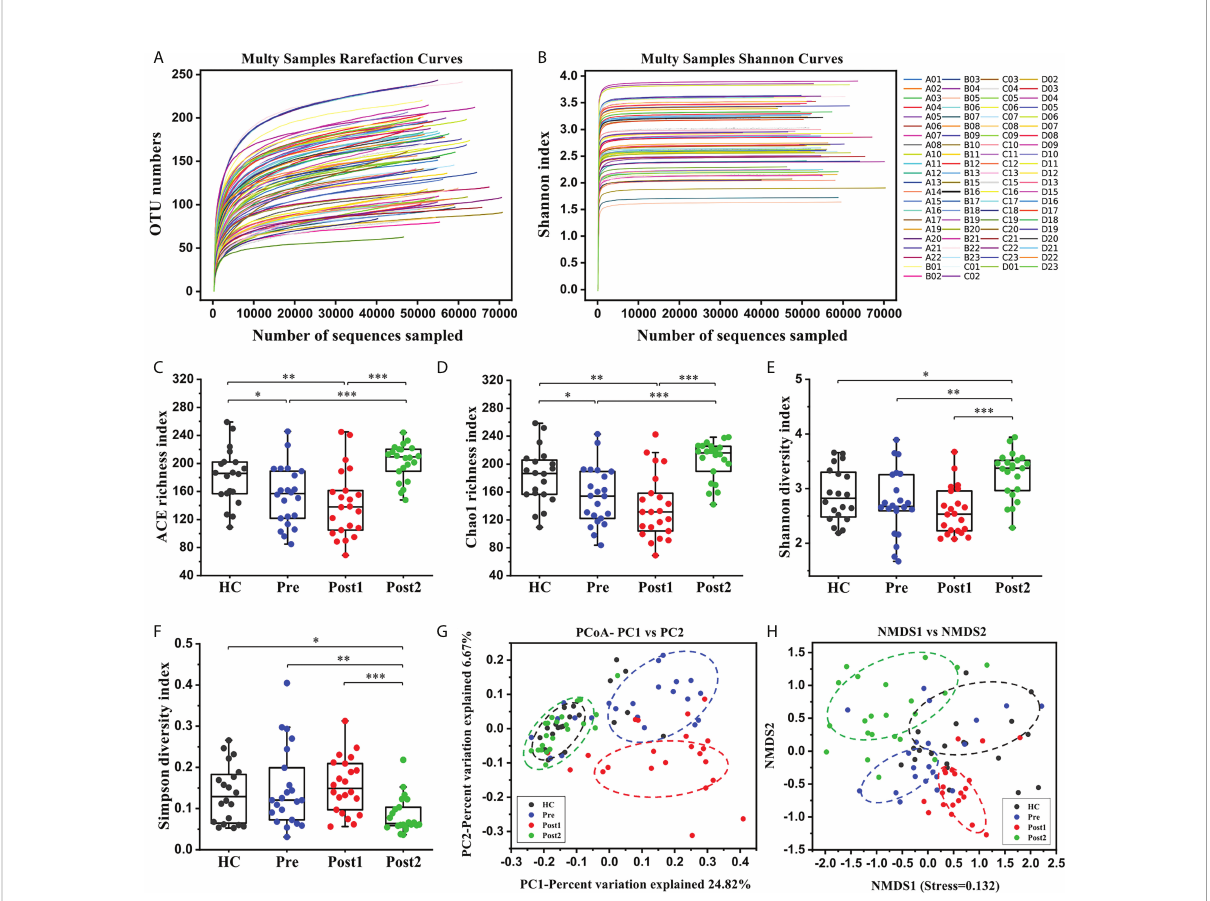
FIGURE 2 The alterations in the gut microbiome diversities and structures in patients after the SPD. (A, B) Rarefaction curves and Shannon curves of the gut microbiome in each sample. (C – F) Comparisons of the microbiome alpha diversity at Pre ( n = 22), Post1 ( n = 22), Post2 ( n = 22), and in the healthy control ( n = 20) groups. Alpha diversity was illustrated by the ACE richness index, Chao1 richness index, Shannon diversity index, and Simpson diversity index. The boxes represent the 25th through the 75th percentile, and the median value is shown as a horizontal line inside the box; the whiskers extend to 1.5 times the difference between the 25th and 75th percentiles. * P < 0.05, ** P < 0.01, *** P < 0.001. (G, H) PCoA score plot based on Binary Jaccard and NMDS score plot based on Weighted